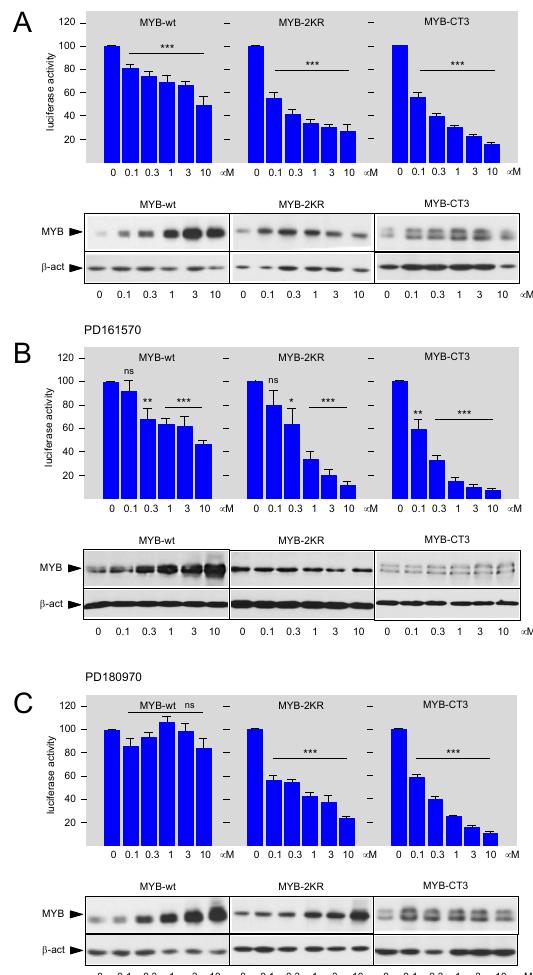
Figure 2. Comparison of the inhibitory activity of selected compounds towards wild-type MYB, MYB-2KR, and C-terminally truncated MYB. HEK293T cells were transfected with expression vectors for wt MYB, MYB-2KR, and MYB-CT3 and the MYB-responsive reporter gene pGL4-5xMRE(GG)-Myc. Transfected cells were distributed in identical aliquots into microtiter plates and treated with the indicated concentrations of Bosutinib ( A ), PD161570 ( B ) or PD180970 ( C ). Cells were harvested after 16 h and used for luciferase assays. Identically treated cells were also analyzed by western blotting to determine MYB expression. Bars depict the average luciferase activity normalized to untreated cells. Asterisks indicate statistical significance (ns: not significant; * p < 0.05; ** p < 0.01; *** p < 0.001; Student’s t -test). The bottom shows relevant parts of the protein gels containing MYB, MYB-2KR, MYB-CT3, and β